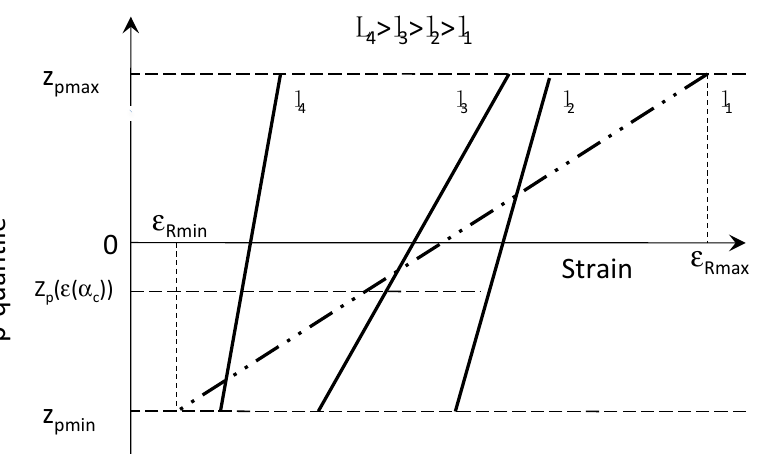
Figure 14. Schematic p-quantile z p ( ε ) diagrams depicting the possible situations in Figure 13.